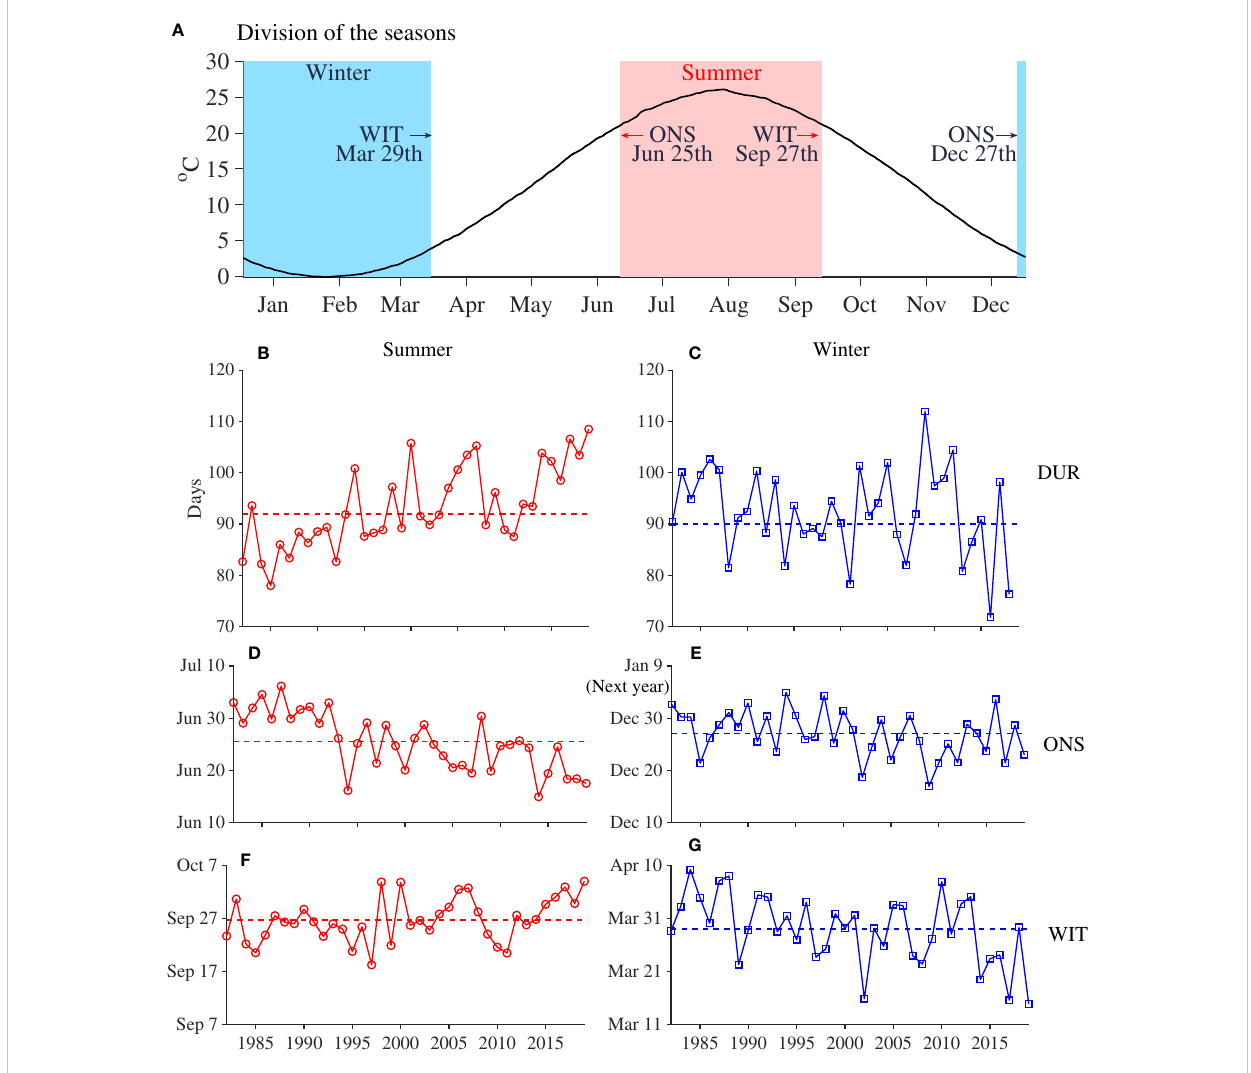
FIGURE 3 (A) Redivision of the summer (shaded in red) and winter (shaded in blue) seasons in the Bohai Sea based on the annual cycle of the daily climatological SST averaged over the period of 1982 – 2019. By implementing this redivision method, (B – G) show the time series of the length and timing indices including duration (DUR), onset (ONS), and withdrawal (WIT) averaged over the Bohai Sea for the summer (left panel) and winter (right panel) seasons,